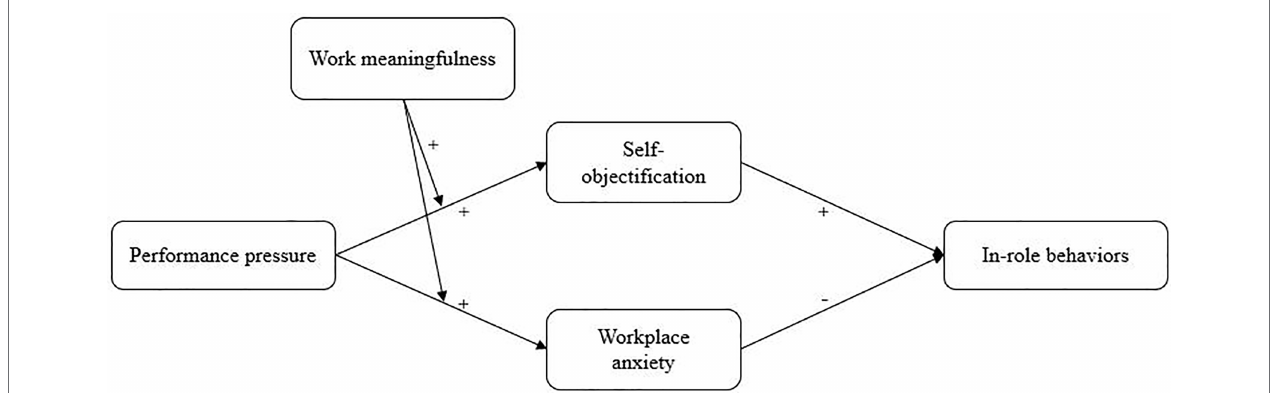
FIGURE 1 | Hypothesized